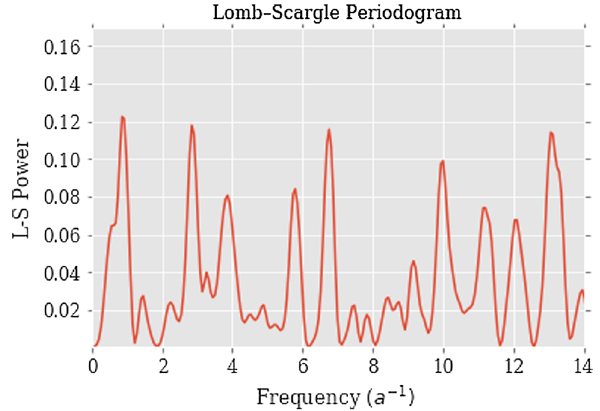
Fig. 3 Relative difference from the mean value of measured 36 Cl at the BNL (applying 0 . 13% uncertainty on individual data) [11]